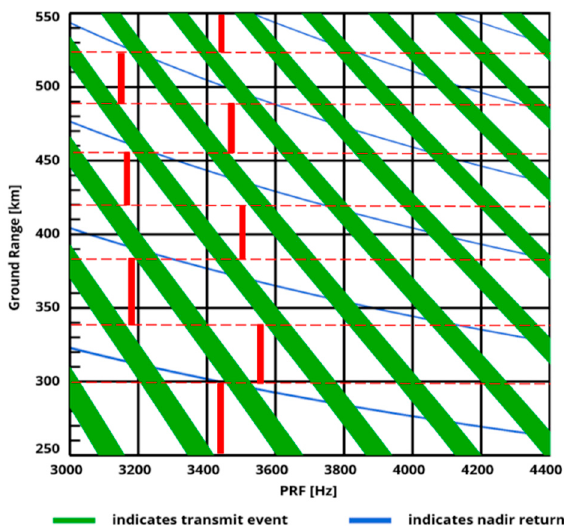
Figure 2. Timing diagram for PRF selection of a conventional SAR. The green and blue areas indicate transmit and nadir interferences, respectively, while the red lines indicate possible swaths that avoid transmit and nadir interferences.